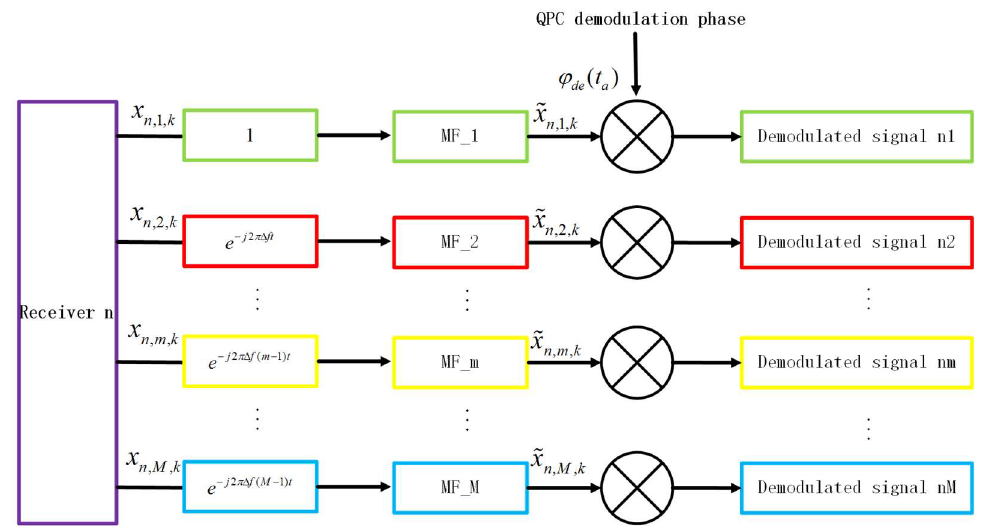
Figure 1. Procedures of receive processing.